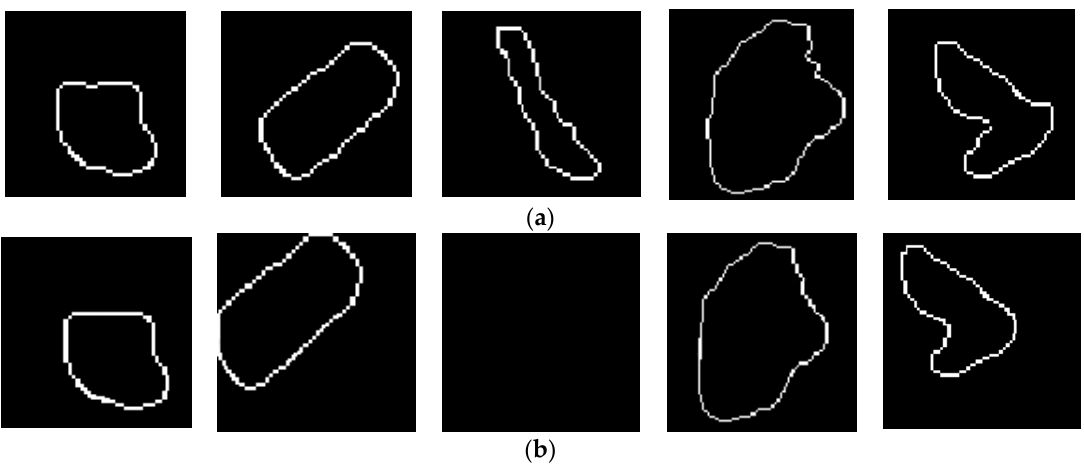
Figure 6. The results of the Sobel operator detection of partial surface defects. The result vacancy represents the loss of target in the tracking process. ( a ) Detection according to the tracking results of the improved kernel correlation filter (KCF) algorithm; ( b ) detection according to the tracking results of the tracking – learning – detection (TLD) algorithm.